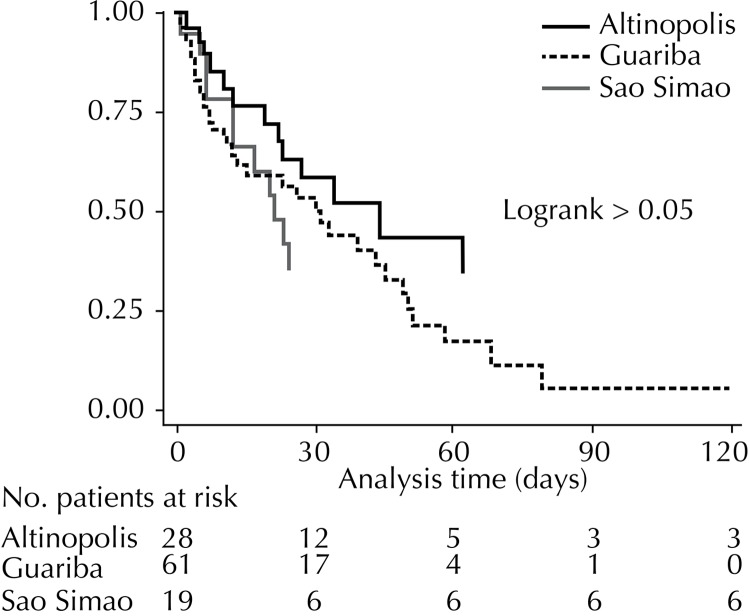
Kaplan-Meier graph for the length of stay of patients in each institution.